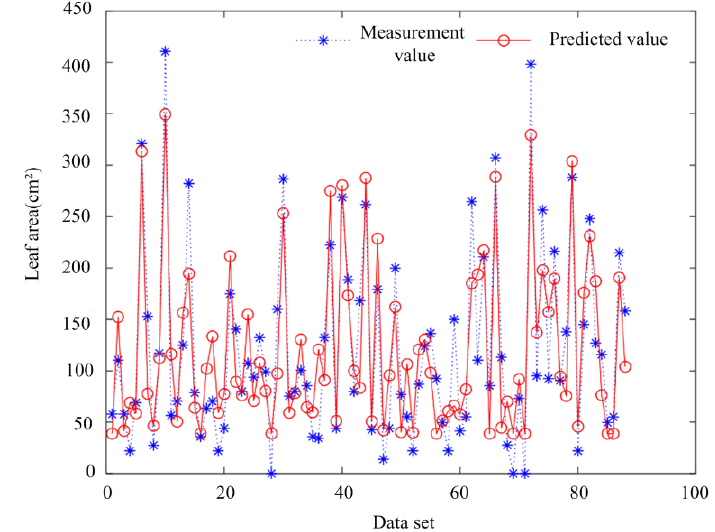
Figure 14. Test set data fitting diagram.